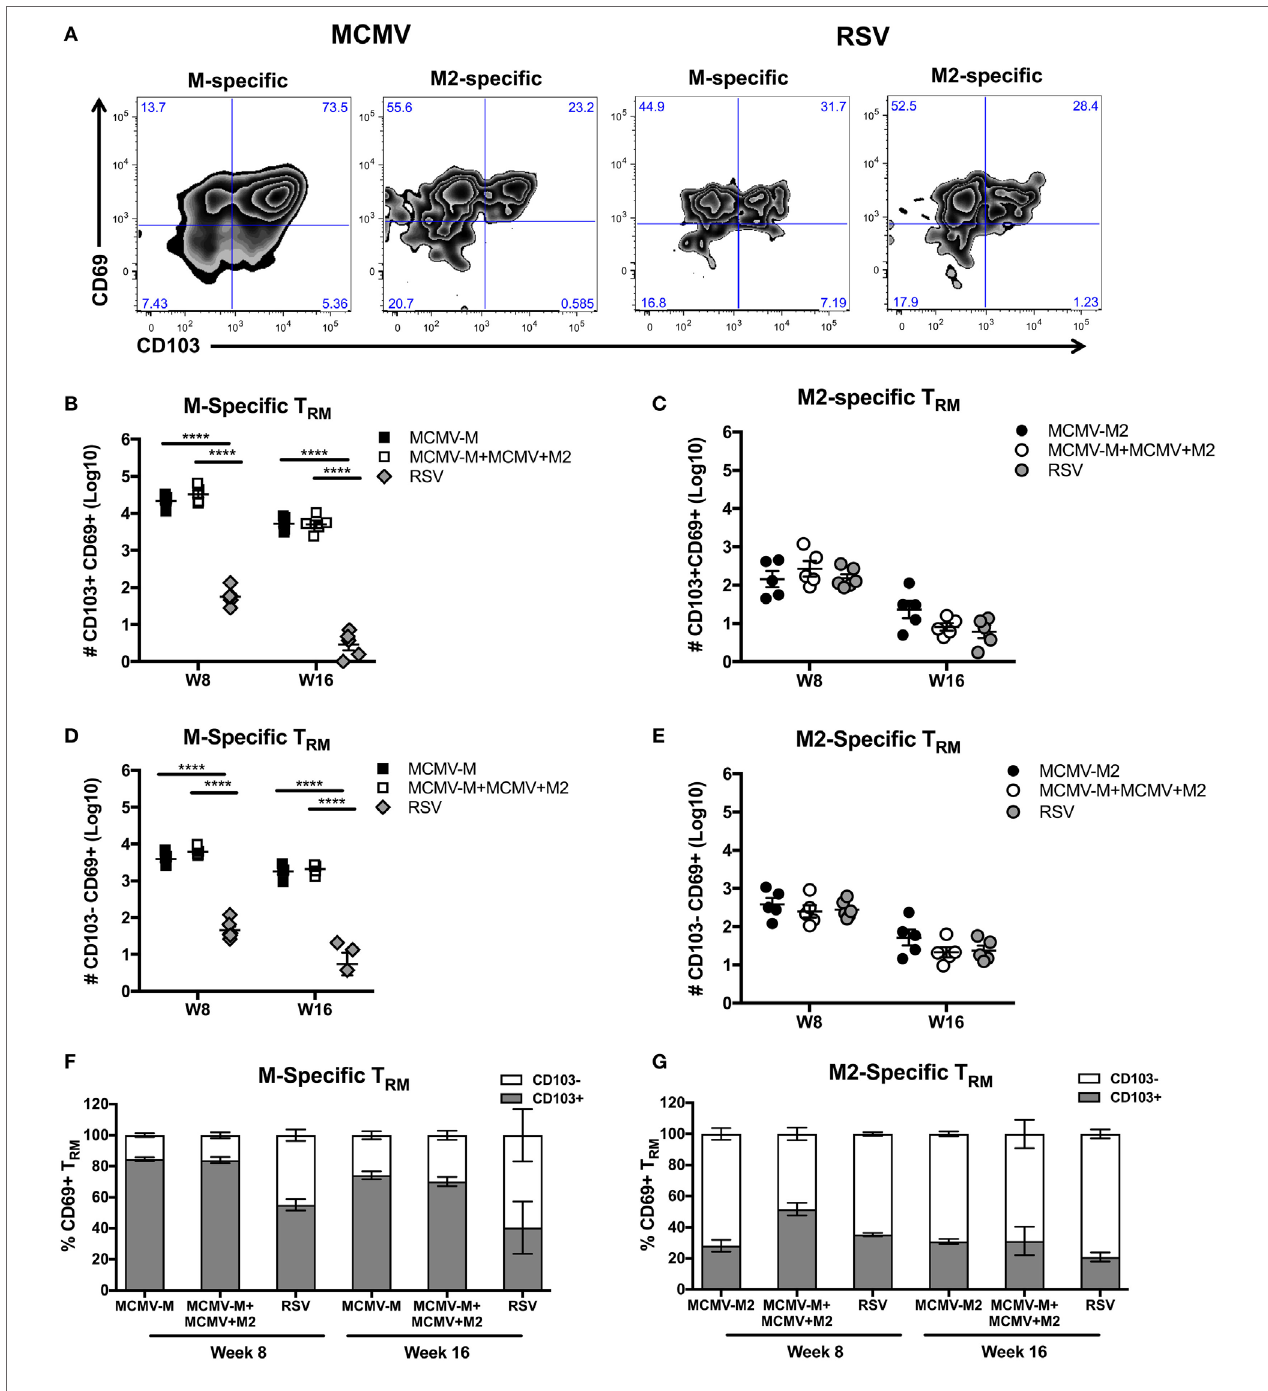
FigUre 4 | Intranasal (IN) vaccination with murine cytomegalovirus (MCMV) elicits CD8 + tissue-resident memory T (T RM ) cells. (a–e) Mice were infected with respiratory syncytial virus (RSV) or vaccinated with MCMV-M or MCMV-M2 alone or a combination of MCMV-M and MCMV-M2 via the IN route. Intravascular staining was used in conjunction with D b /M 187–195 and K d /M2 82–90 tetramers to quantify M-specific (a,B,D,F) and M2-specific (a,c,e,g) CD8 + T cells in the lung tissue at weeks 8 (W8) and 16 (W16). (a) Representative flow cytometry plots showing expression of CD69 and CD103 on epitope-specific CD8 + T cells in the lung parenchyma at week 8. (B,D) The number of M-specific CD103 + CD69 + T RM cells (B) and CD103 − CD69 + T RM cells (D) elicited by infection with RSV or vaccination with MCMV-M alone or together with MCMV-M2. (c,e) The number of M2-specific CD103 + CD69 + T RM cells (c) and CD103 − CD69 + T RM cells (e) elicited by infection with RSV or vaccination with MCMV-M2 alone or together with MCMV-M. (F,g) Percentage of CD103 + and CD103 − M-specific CD69 + T RM cells (F) and M2-specific CD69 + T RM cells (g) . **** P < 0.0001 by two-way ANOVA. Bars indicate mean ± SEM ( n = 5 mice/group). Data are shown from one experiment and representative of two independent